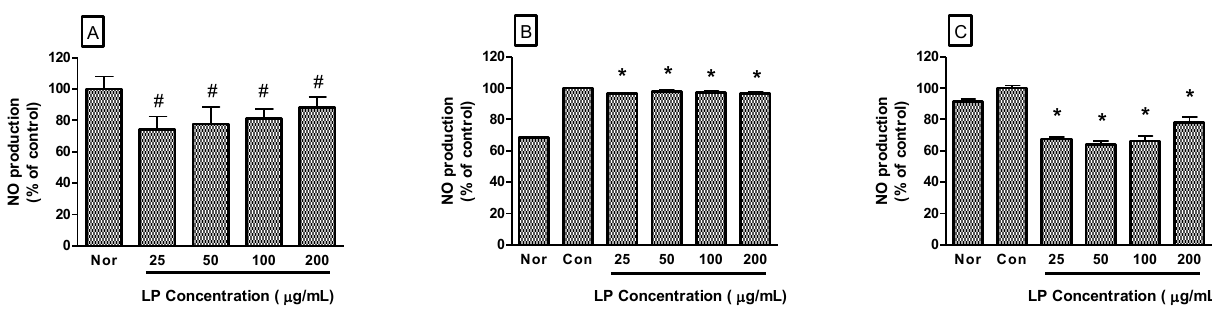
78.19% ± 3.47% of the control (LPS only) value ( p < 0.05), respectively (Figure 2C). Figure 2. Effects of LP on NO production in RAW 264.7 macrophages for 24 h ( A ) or LPS-stimulated RAW 264.7 macrophages for 16 h ( B ) and 24 h incubation ( C ). NO production was measured by the Griess reaction assay and is expressed as a percentage of the normal (Nor; medium only) or the control (Con; LPS alone). Values are the mean ± SEM of three independent experiments. # p < 0.05 vs. Nor; * p < 0.05 vs. LPS (1 μg/mL) alone.